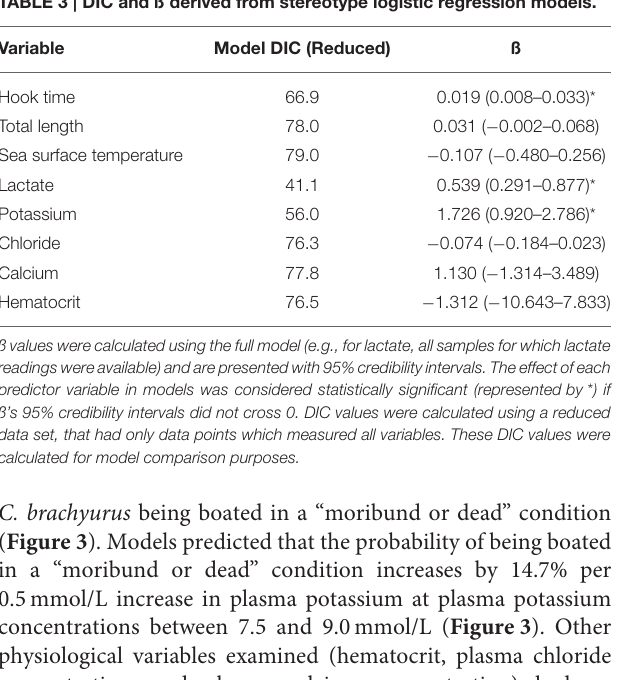
TABLE 3 | DIC and ß derived from stereotype logistic regression